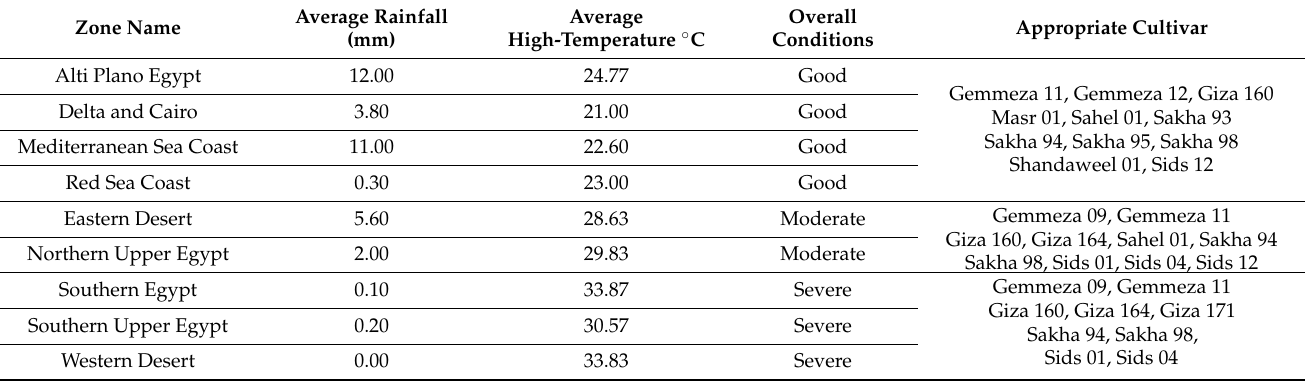
Table 7. Average rainfall and high temperature from March to May 2021 and the most appropriate cultivar(s) to each